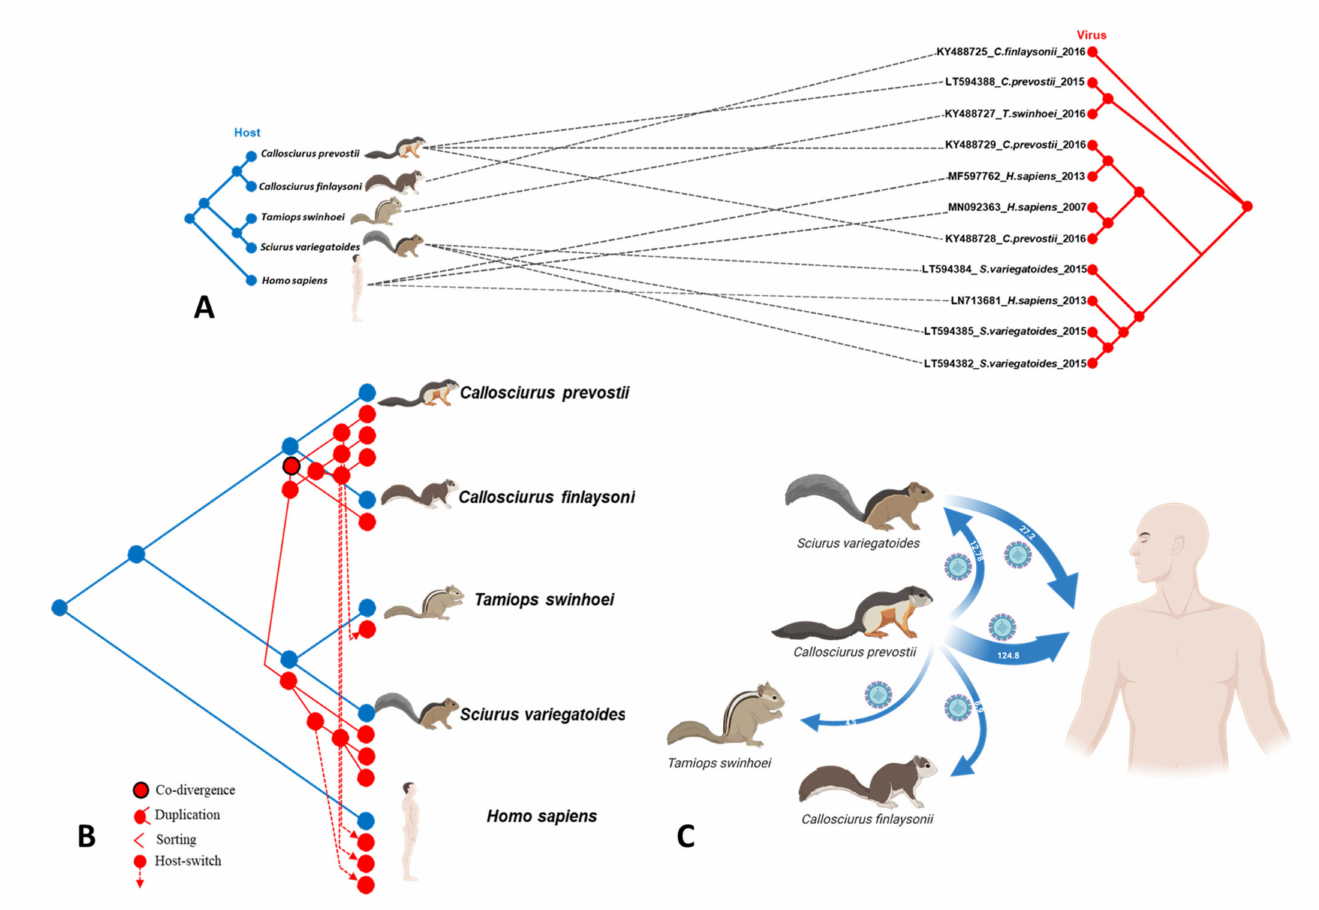
Figure 2. Host-parasite systems of mammalian hosts and VSBV-1 and transmission strengths of squirrel-derived VSBV-1 strains. ( A ) Co-phylogenetic reconstruction of the relationship between VSBV-1 and its known hosts based on complete coding-region alignments of VSBV-1 and taxonomic relationships of hosts based on the mtDNA cyt b gene phylogeny using CoRe-PA software. The blue tree represents the phylogeny of the hosts, while the red tree the phylogeny of VSBV-1. ( B ) Representation of the most parsimonious co-evolutionary reconciliation scenario for VSBV-1 and its known hosts proposed by CoRe-PA. Four evolutionary events are denoted: co-divergence, duplication, sorting, and host switches. Dashed red lines indicate distant host jump events. ( C ) Connectivity and magnitude of transmission network of VSBV-1 in host species. Arrows indicate the origin and direction of transmission of VSBV-1 between host species and arrow widths are proportional to the strength of the transmission rate (Bayes factor, BF). Figure 3C and the silhouettes of figures were created with